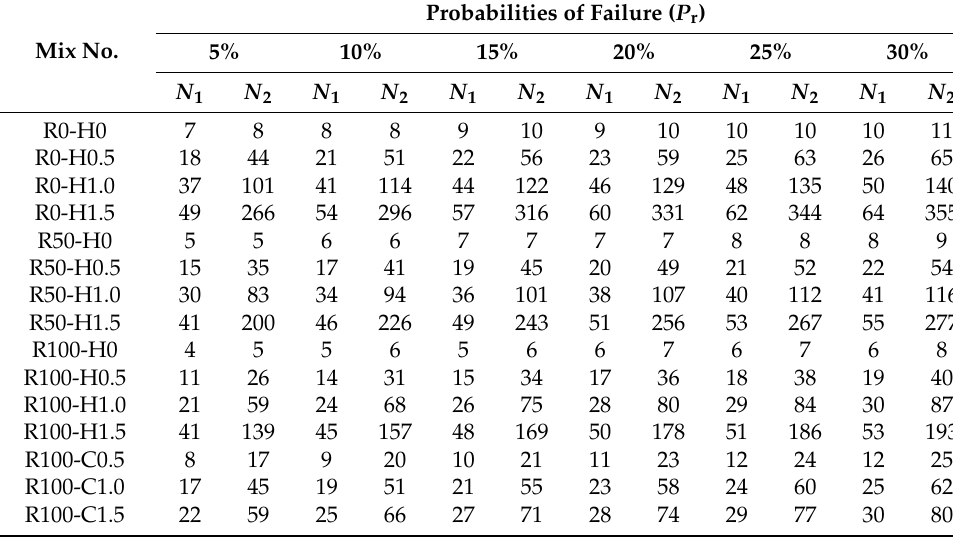
Figure 14. The curves of P r – N 2 – V f : ( a ) R0-H; ( b ) R50-H; ( c ) R100-H; ( d ) R100-C. Table 9. Impact resistance times of SFRAC under different probabilities of